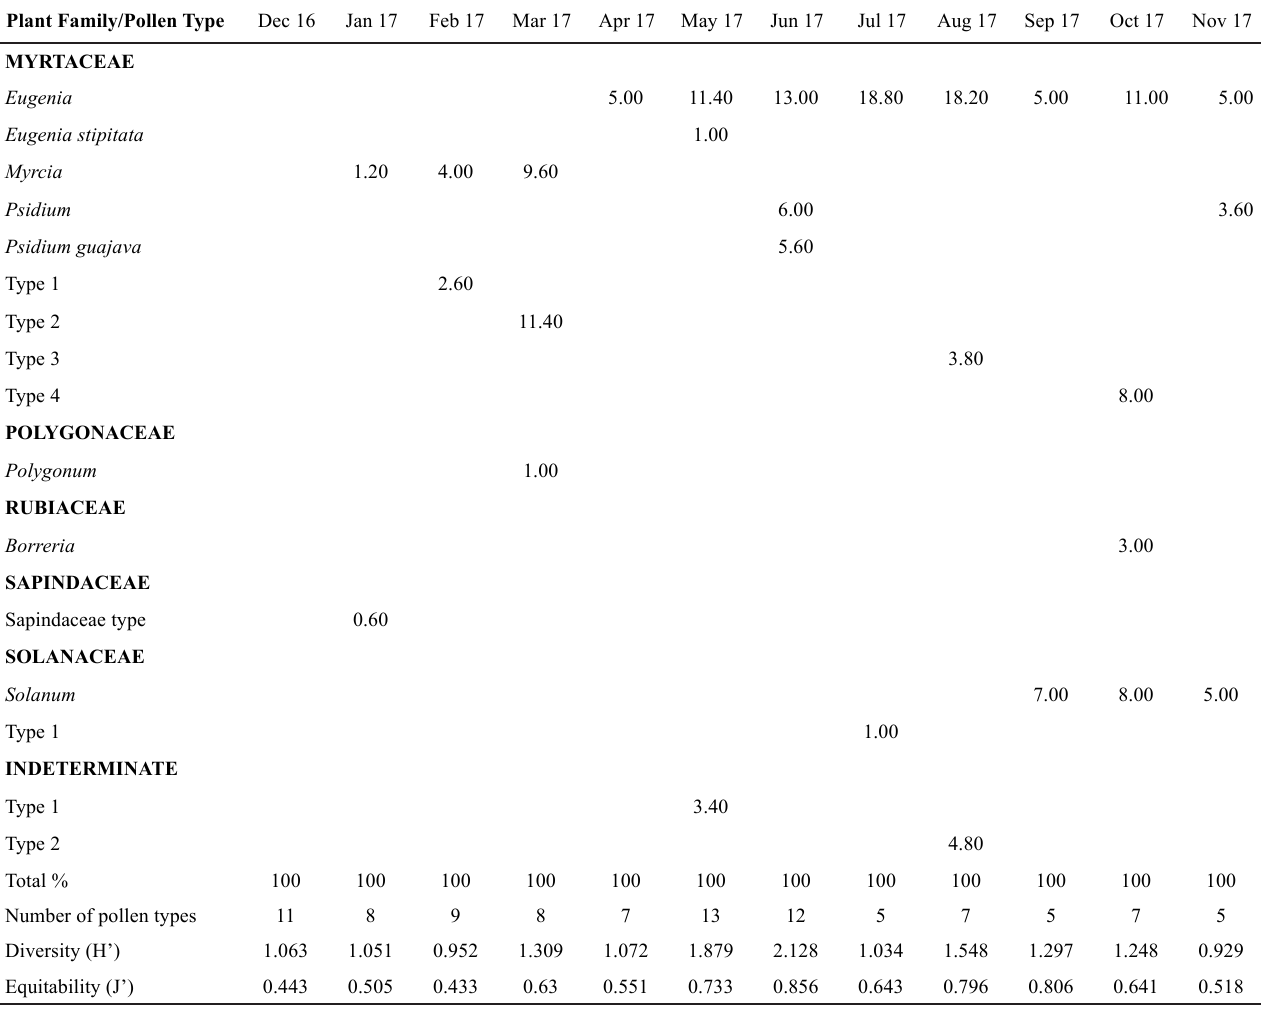
Table 2 . Frequency of pollen types found in honey samples of Melipona interrupta (Apidae: Meliponini) collected from December 2016 (Dec 16) to November 2017 (Nov 17) in the community of Vila Franca, Tapajós-Arapiuns Extractive Reserve, Santarém (PA), Brazil.